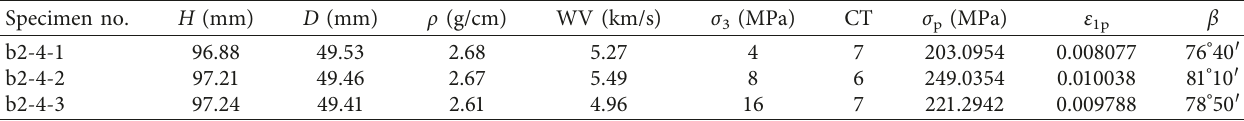
Table 3: Test results of rock specimens under cyclic loading-unloading conditions. Specimen no.